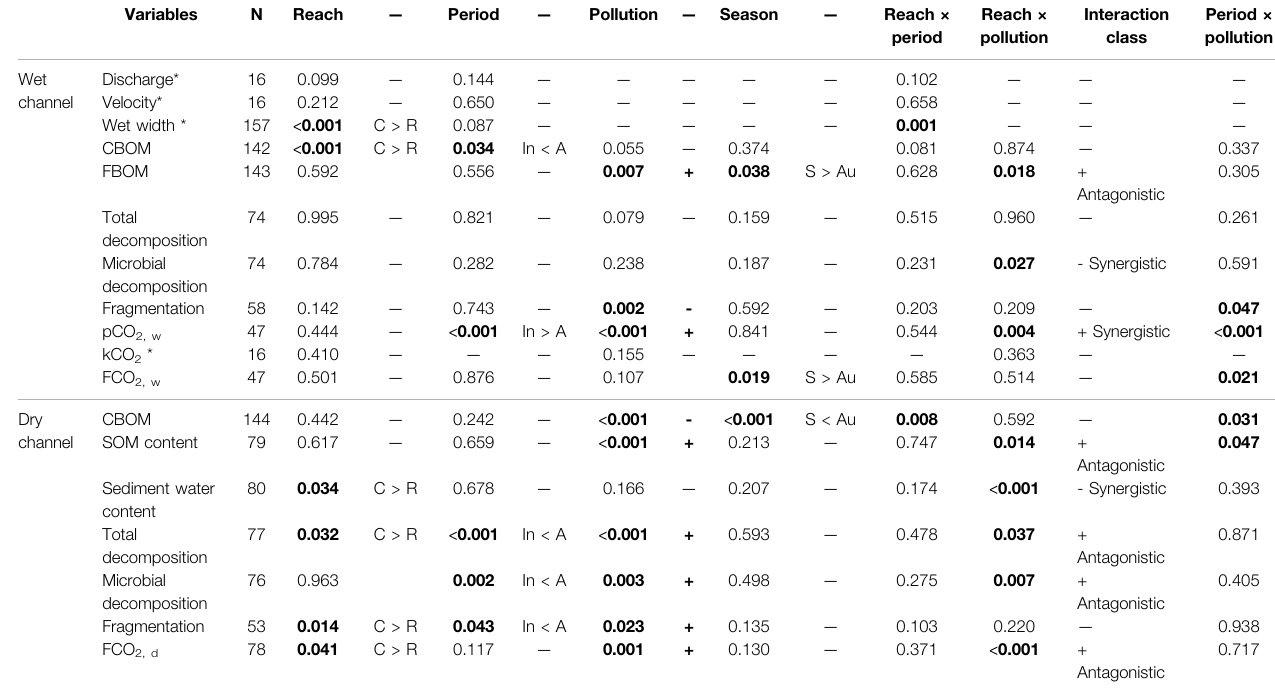
TABLE3| Resultsoflinearmodelstestingfortheeffectsofreach,status,pollutionandseasononvariablesmeasuredinthewetandthedrychannel.CBOM=coarsebenthic organic matter, FBOM = fi ne benthic organic matter, pCO 2,w = CO 2 partial pressure in water, kCO 2 = CO 2 reaeration coef fi cient, FCO 2,w = CO 2 fl ux between water and atmosphere,FCO 2,d =CO 2 fl uxbetweendryriverbedandatmosphere,SOM=sedimentorganicmatter.p-ValueswereobtainedbyANOVA.Signi fi cantp-valuesareshown inbold.Numberofdataused(N)isshown.Signofthecoef fi cientsandcomparisonsbetweenlevelsofmainsigni fi canteffectsaregiven(C:control;R:Regulated;In:Inactive; A: active; +: increase; -: decrease; S: Spring; Au: Autumn). Interaction class corresponds to reach and pollution interaction and it was classi fi ed following Piggott et al. (2015). * Given the limited replication a simpler model was used for the statistical analysis.